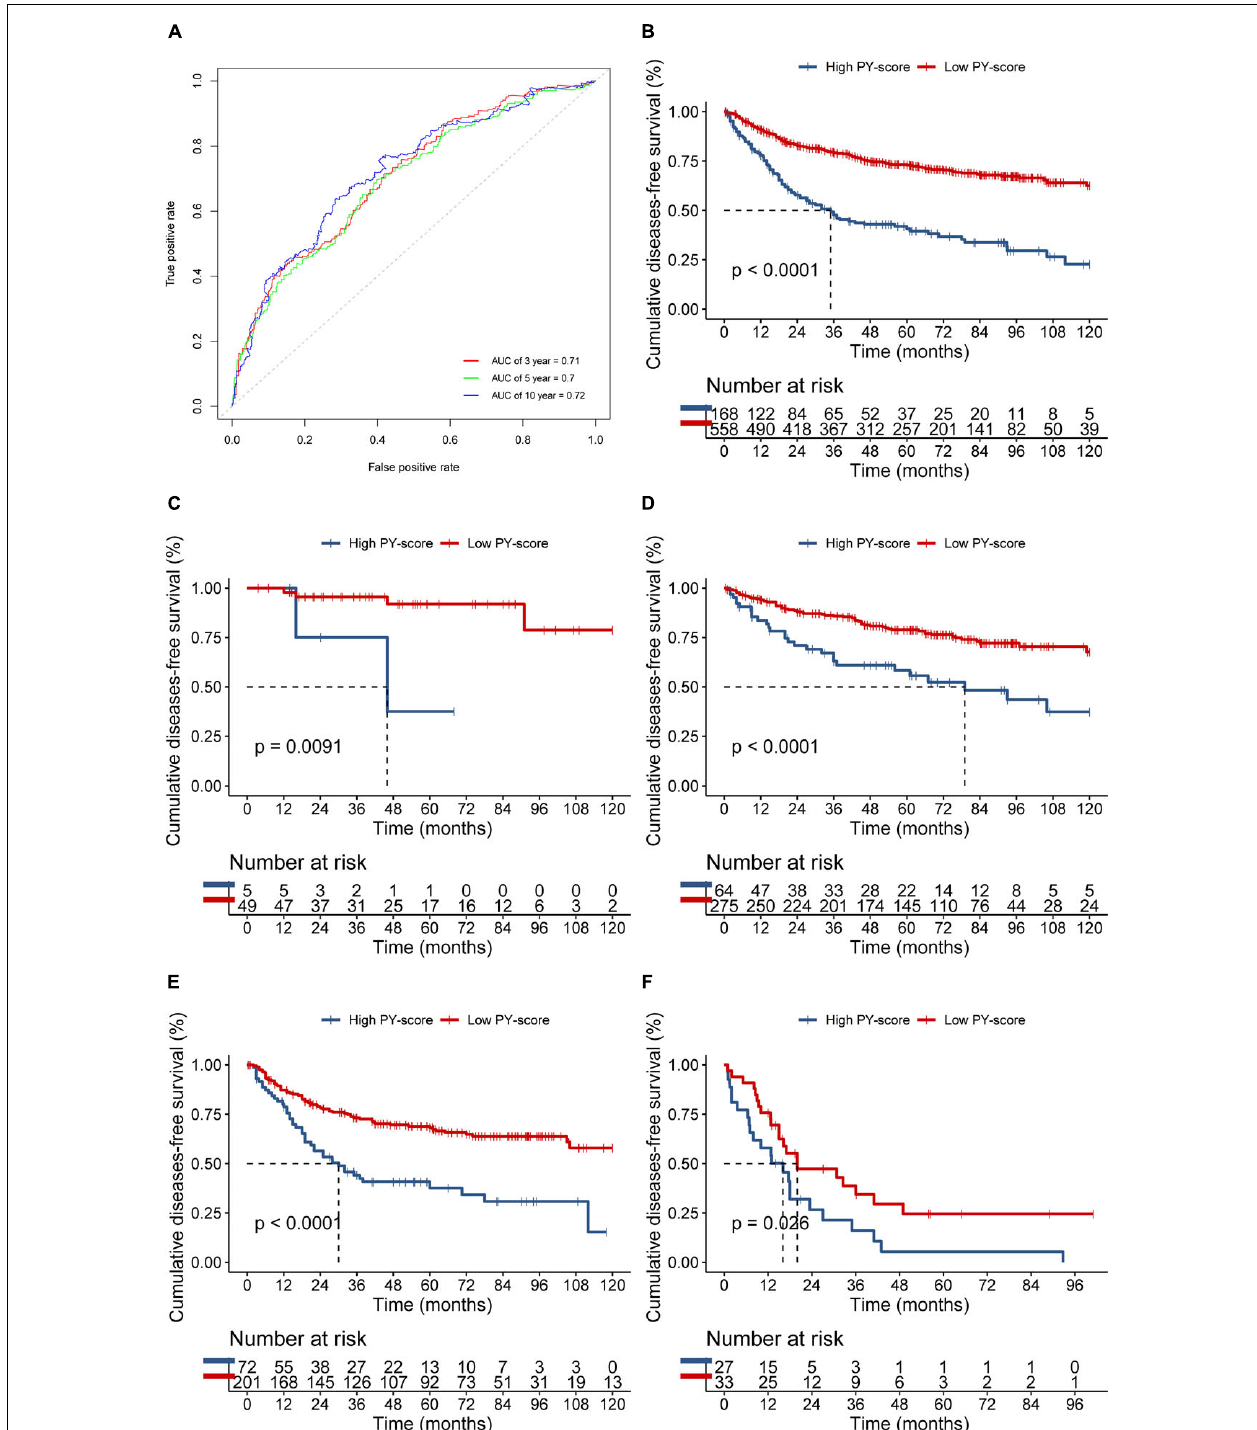
FIGURE 5 | Role of the pyroptosis score (PY-score) in predicting the survival of colon cancer patients in the meta-GEO (Gene Expression Omnibus) cohort. (A) Predictive value of the PY-score in colon cancer patients from the meta-GEO cohort. (B) Survival analyses for patients in the low (558 cases) and high (168 cases) PY-score groups in the meta-GEO cohort using Kaplan–Meier curves ( p < 0.001). (C–E) Survival analyses for tumor node metastasis (TNM) stage 0 and I patients in the low (49 cases) and high (5 cases) PY-score groups ( p = 0.0091) (C) , TNM stage II patients in the low (275 cases) and high (64 cases) PY-score groups ( p < 0.001) (D) , TNM stage III patients from the low (201 cases) and high (72 cases) PY-score groups ( p < 0.001) (E) , and TNM stage IV patients from the low (33 cases) and high (27 cases) PY-score groups ( p = 0.026) (F) from the meta-GEO cohort using Kaplan–Meier curves.